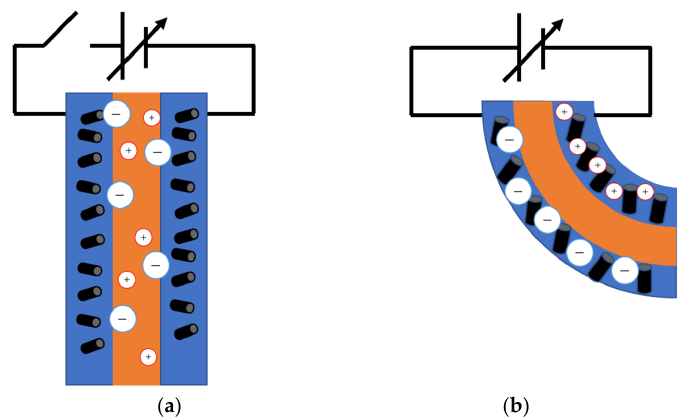
Figure 2. Operation of actuator. ( a ) Before applying voltage. ( b ) After applying voltage.